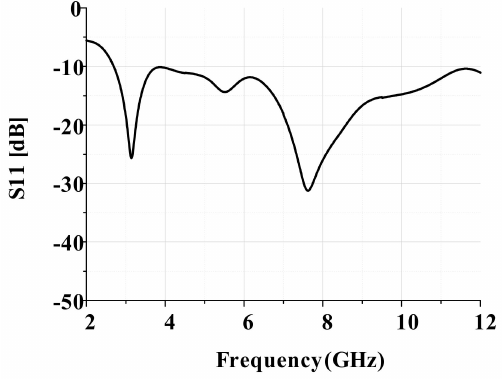
Figure 3. Simulated reflection coe ffi cients of the proposed UWB antenna.